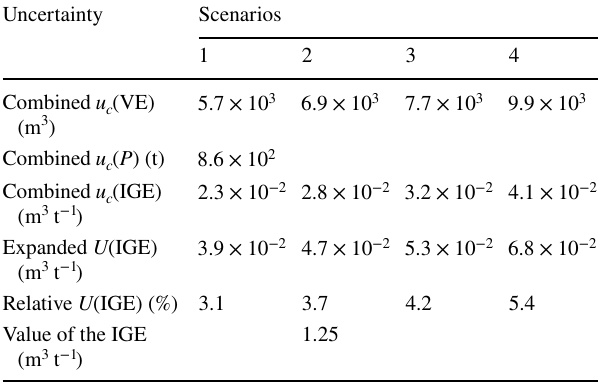
3.0 × 10 5 m 3 ∕ month and a total pro- 2.4 × 10 5 t ∕ month